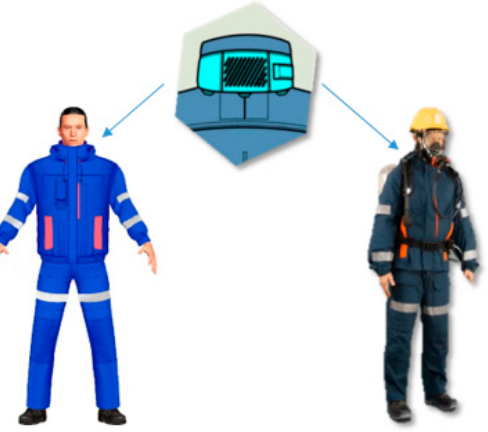
Figure 2. A view of protective clothing with PCM elements on the collar.